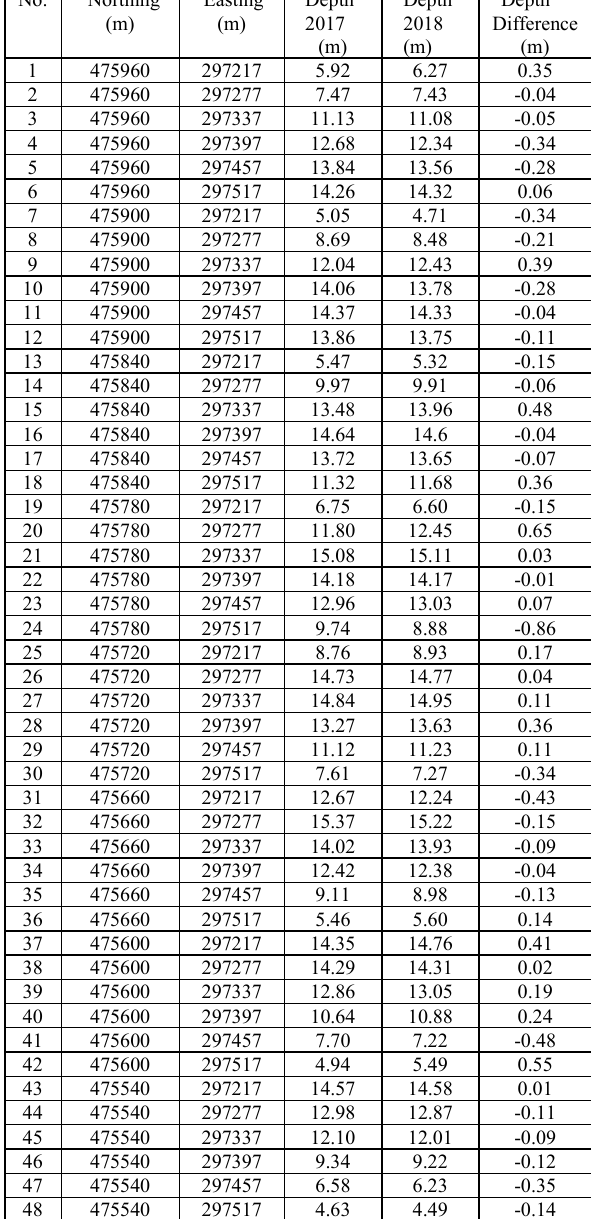
Table 4. Depth comparison between 2017 and 2018 relative